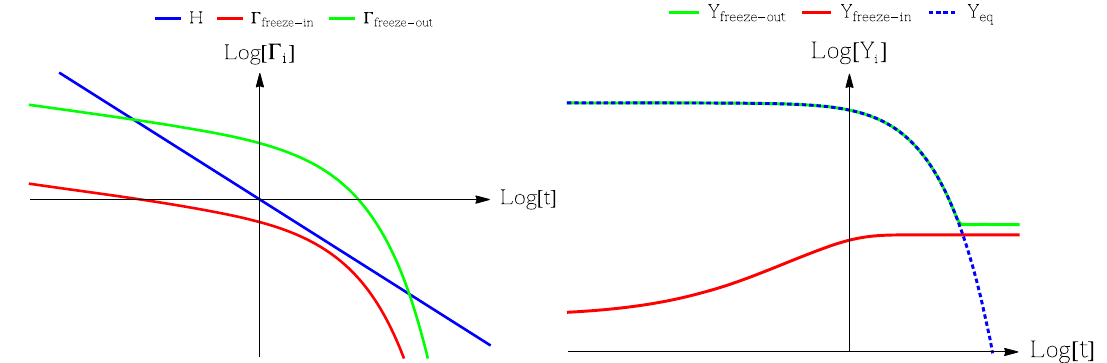
between the freeze-out case (green) and the freeze-in case (red) results from the much smaller coupling in the freeze-in case. The right panel shows the corresponding number densities compared to the equilibrium density in a co-moving